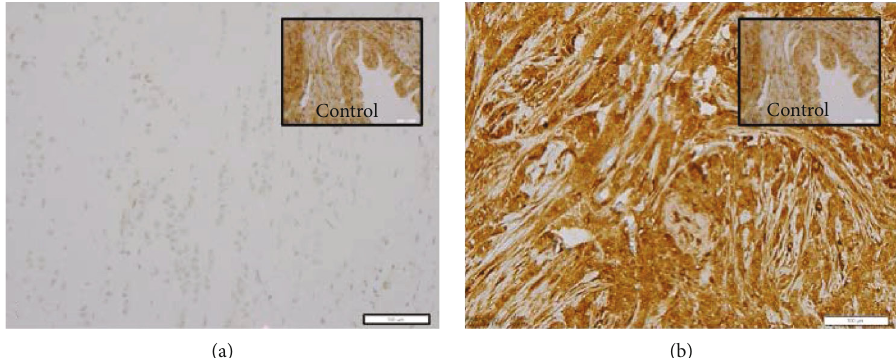
Figure 2: PTEN IHC results (20x for both rumors, 40x for controls): (a) PTEN negative ILC tumor with positive control; (b) high PTEN expression in a representative PILC tumor tissue with positive control.